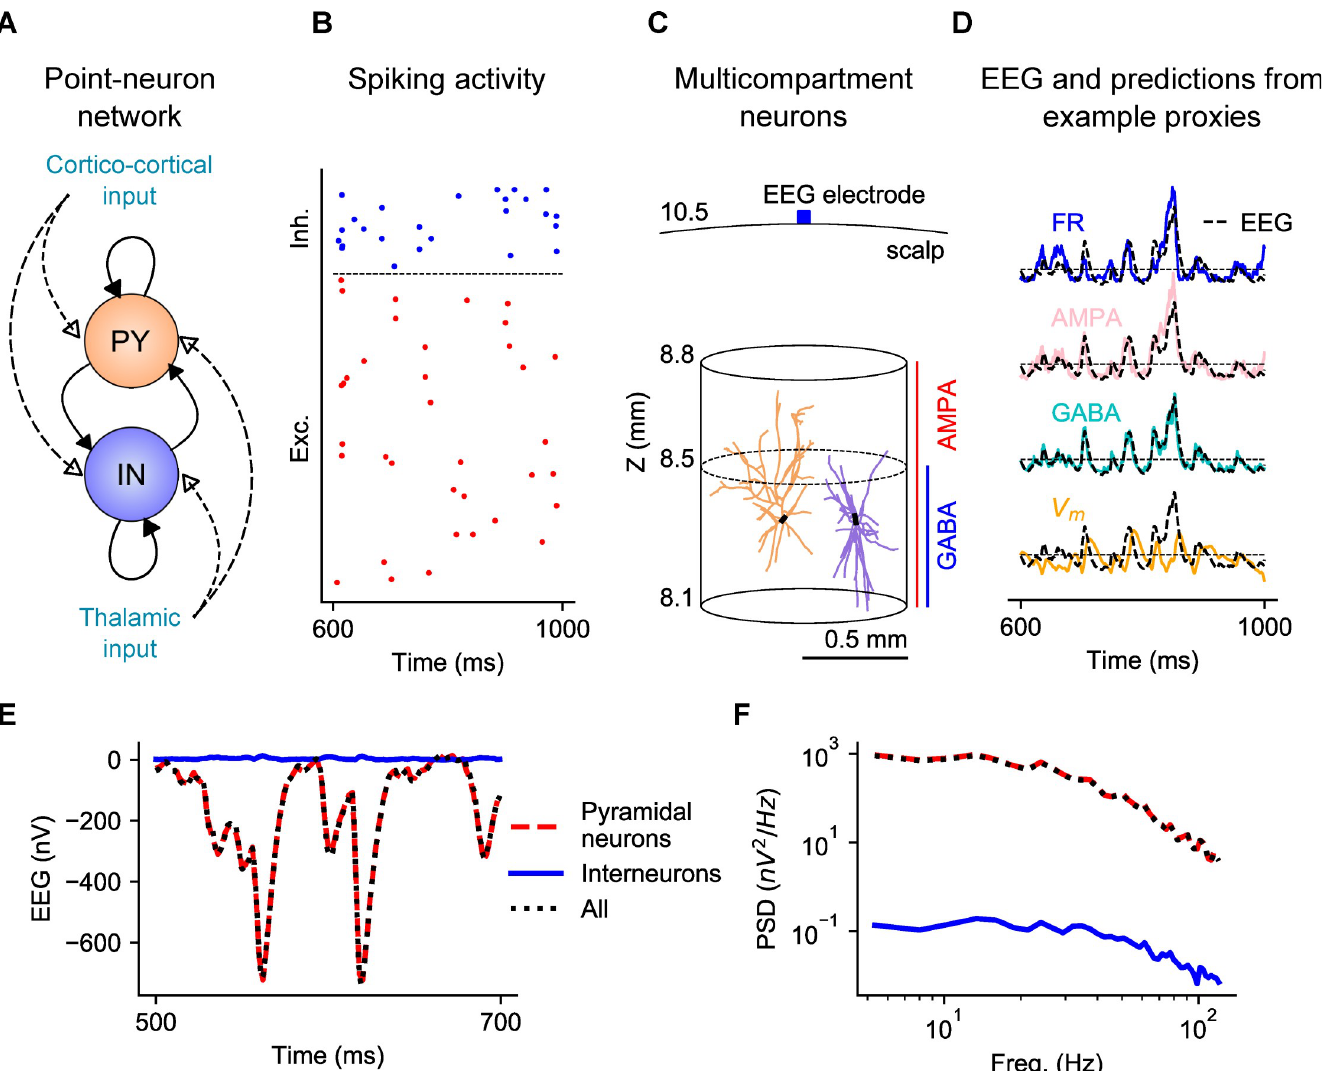
Fig 1. Overview of the network models and computation of proxies and EEG. (A) Sketch of the point-neuron network with recurrent connections between two types of populations: excitatory cells (pyramidal cells, PY) and inhibitory cells (interneurons, IN). Each population receives two kinds of external inputs: global ongoing cortico-cortical activity and thalamic stimulation. (B) Raster plot of spiking activity from a subset of cells in each population. (C) Sketch of the multicompartment neuron models used for generation of the EEG. Two representative model neurons are depicted, a pyramidal cell on the left and an interneuron on the right, positioned within a cylinder of r = 0.5 mm. While AMPA synapses are homogenously distributed over all compartments of both types of cells, GABA synapses on pyramidal cells are located only below Z = 8.5 mm. The EEG recording electrode is situated on the surface of the scalp layer. (D) Comparison between example proxies calculated from the point-neuron network and the ground-truth EEG computed from the multicompartment neuron model network. (E) EEG generated in the multicompartment neuron network by all neurons (dotted black), only pyramidal neurons (dashed red) or only interneurons (solid blue). (F) Corresponding power spectra for the three sets depicted in